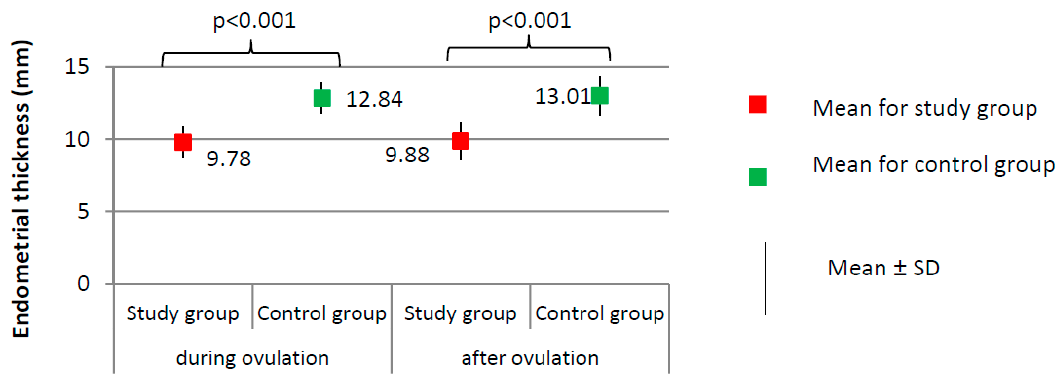
Figure 3. Comparison of endometrial thickness between the study group ( N = 205) and the control group ( N = 100).